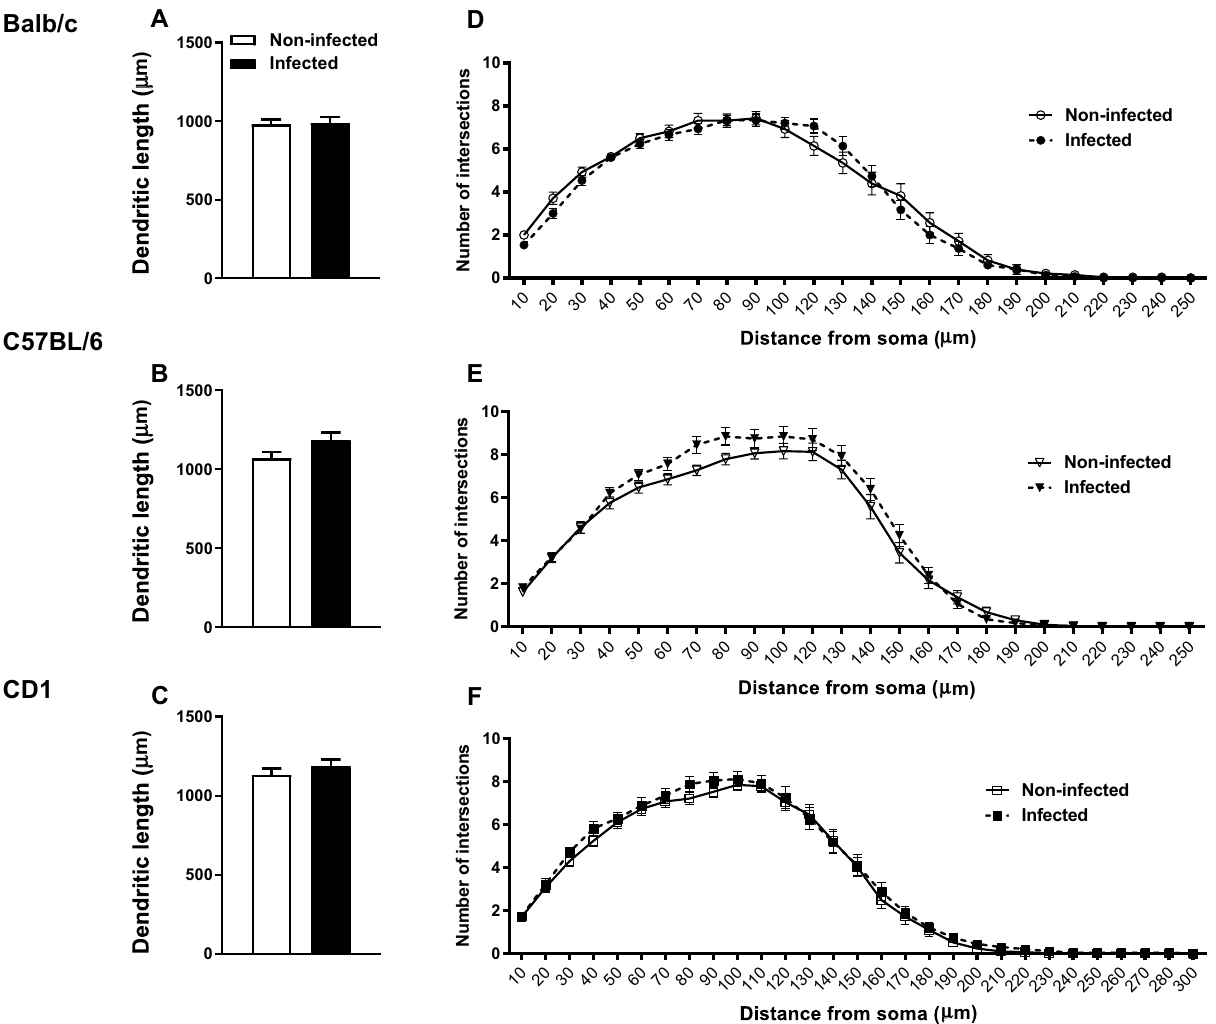
Figure 4. Infection with M. avium does not induce morphological alterations in granule neurons of the hippocampus. Dendritic morphology of granule neurons from the DG was analyzed in M. avium infected (4 wpi) and non-infected Balb/c, C57BL/6 and CD1 mice. The total length of the dendritic tree ( A – C ) and Sholl analysis of the number of intersections of dendrites at specific distances from the soma are displayed ( D – F ). Each bar represents the mean + SEM of the average length of 28–31 granule neurons per group, from 5 to 6 mice per group; the lines represent the average number of intersections of dendrite branches with consecutive 10 µm-spaced concentric spheres of the same